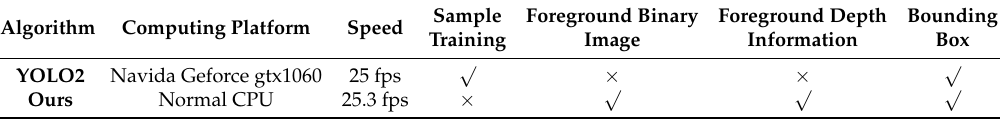
Figure 7. The detection results of YOLO2 [26] and our method in the nighttime scenes with some French windows. For pedestrian detection algorithms, this kind of scenario has a special challenge in addition to the common problems of the night scenarios, i.e., the presence of mirror images in the scene can interfere with the pedestrian detection. Table 3. Algorithm performance comparison with YOLO2